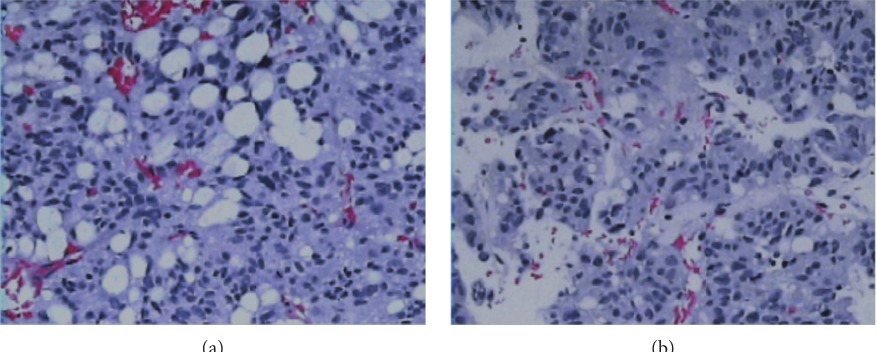
Figure 3: Hematoxylin and eosin staining of the patient’s pituitary adenoma (a, b, × 200). Tumor tissue was composed of cytoplasmic-rich glandular cells arranged in clusters and featuring rounded nuclei. Cells arranged around the blood vessels and formed papillary structures with little